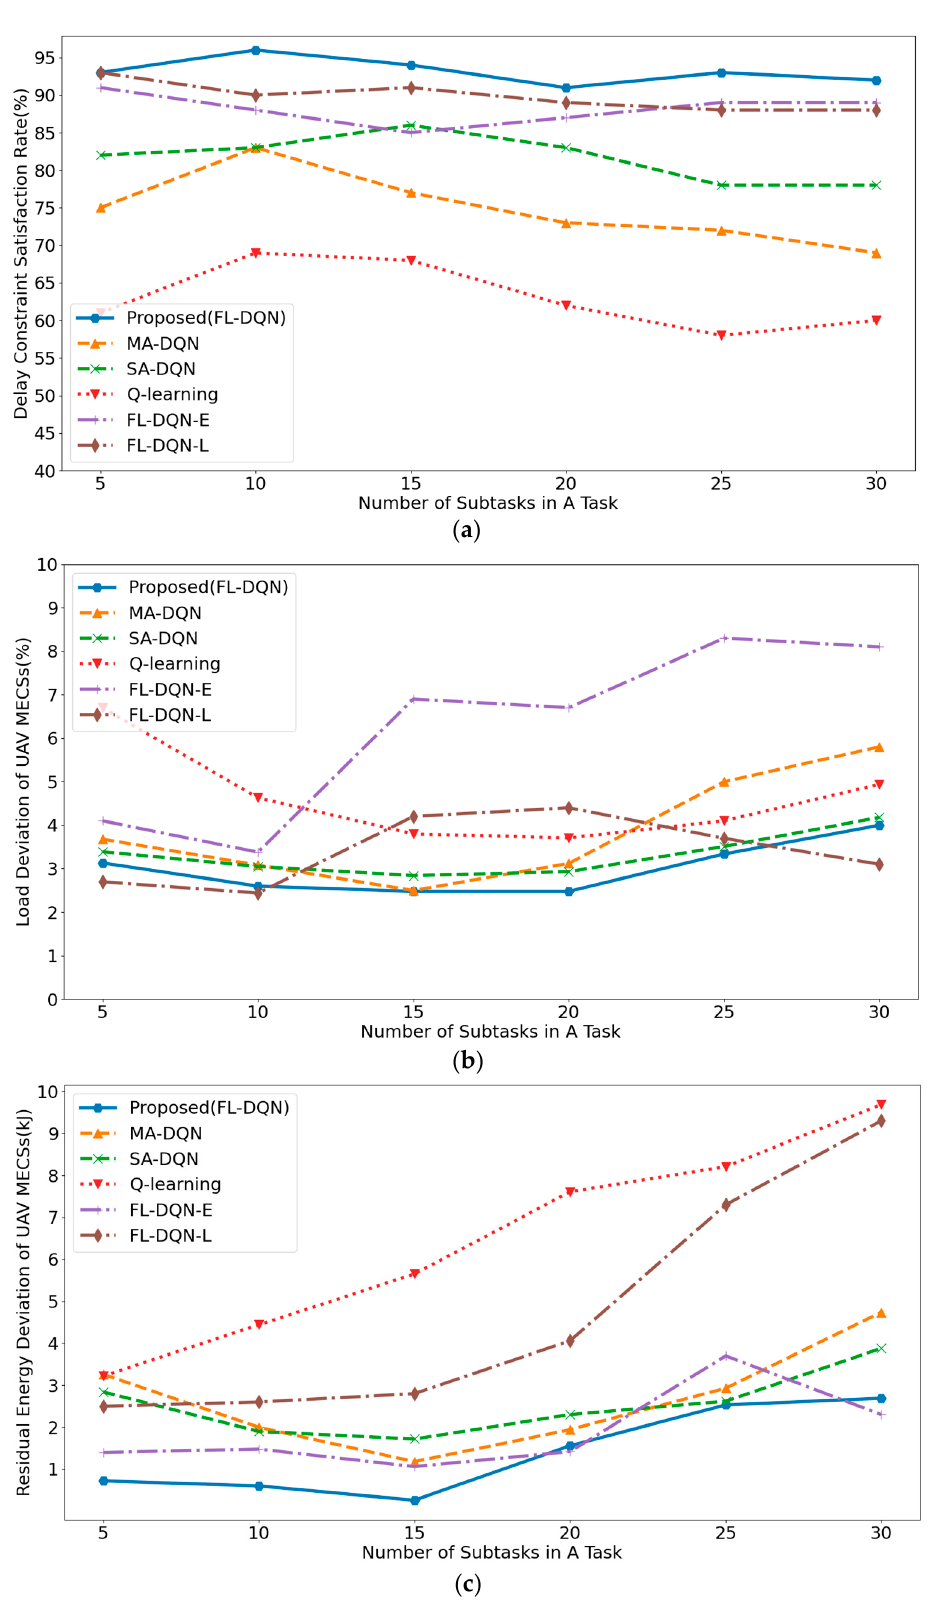
Figure 10. Experimental results with varying number of subtasks in a task: ( a ) delay constraint satisfaction rate; ( b ) load deviation of UAV MECSs; ( c ) residual energy deviation of UAV MECSs.